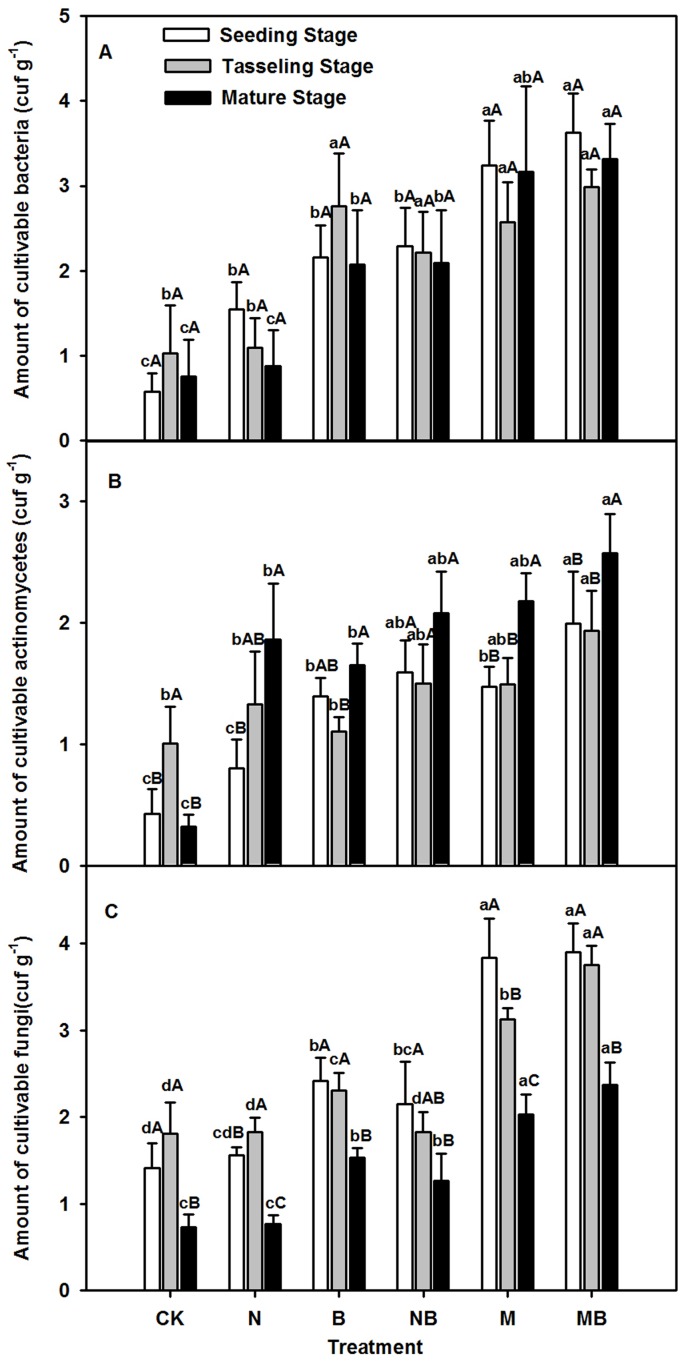
The clony-forming units of bacteria, fungi and actinomyces in various treatments during maize growth stages.CK: no fertilizer; N: N fertilizer; B: bacteria fertilizer; NB: N fertilizer + bacteria fertilizer; M: manure compost; MB: manure compost + bacteria fertilizer. Data are means ± SD (n = 3). Different lower case letters indicate significant differences (ANOVA, LSD test, p<0.05) among fertilizer treatments; different upper case letters indicate significant differences among maize growth stages.